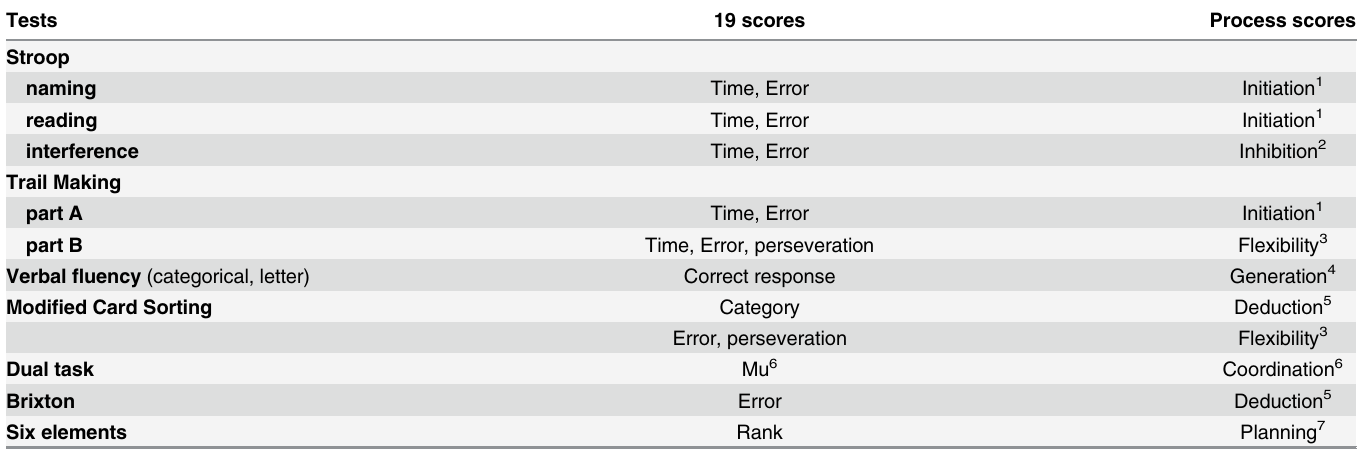
Table 2. Scores in the battery and their combination into seven executive process